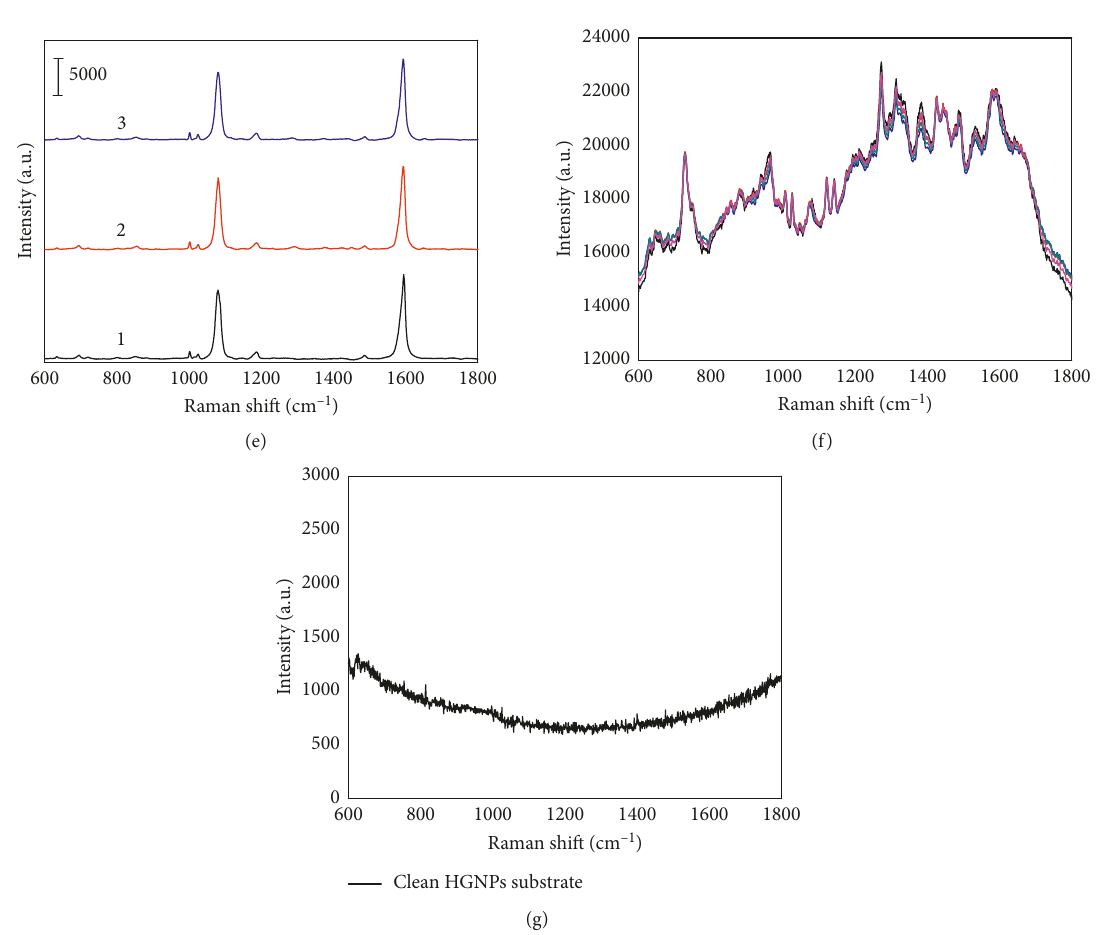
Figure 3: (a) SERS stability of HGNP substrates measured with 4-MBA (1 several days at room temperature. (b) SERS intensities of the bands at 1080cm of 4-MBA at different concentrations (5 substrates. (d) The Raman intensity of 4-MBA at 1080cm 4-MBA at the concentration from 1 (f) The repeatability of the SERS spectrum of serum on the substrate. (g) SERS spectra of unlabeled HGNP